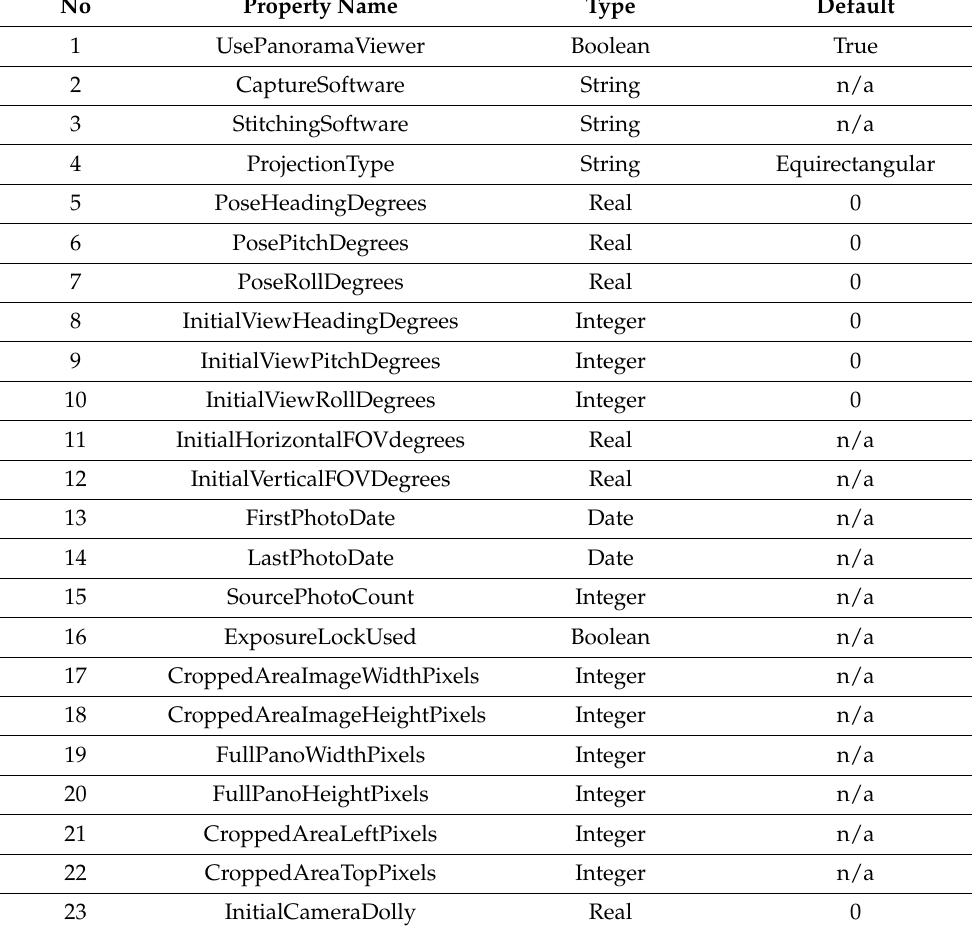
Table 4. GPano metadata